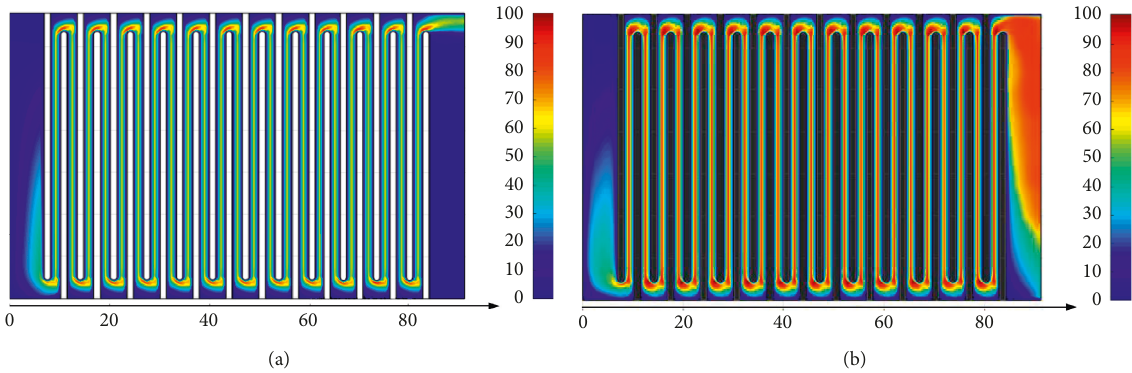
Figure 3: The distribution of the concentration of iron at the initial time (a) and after 240min (b).